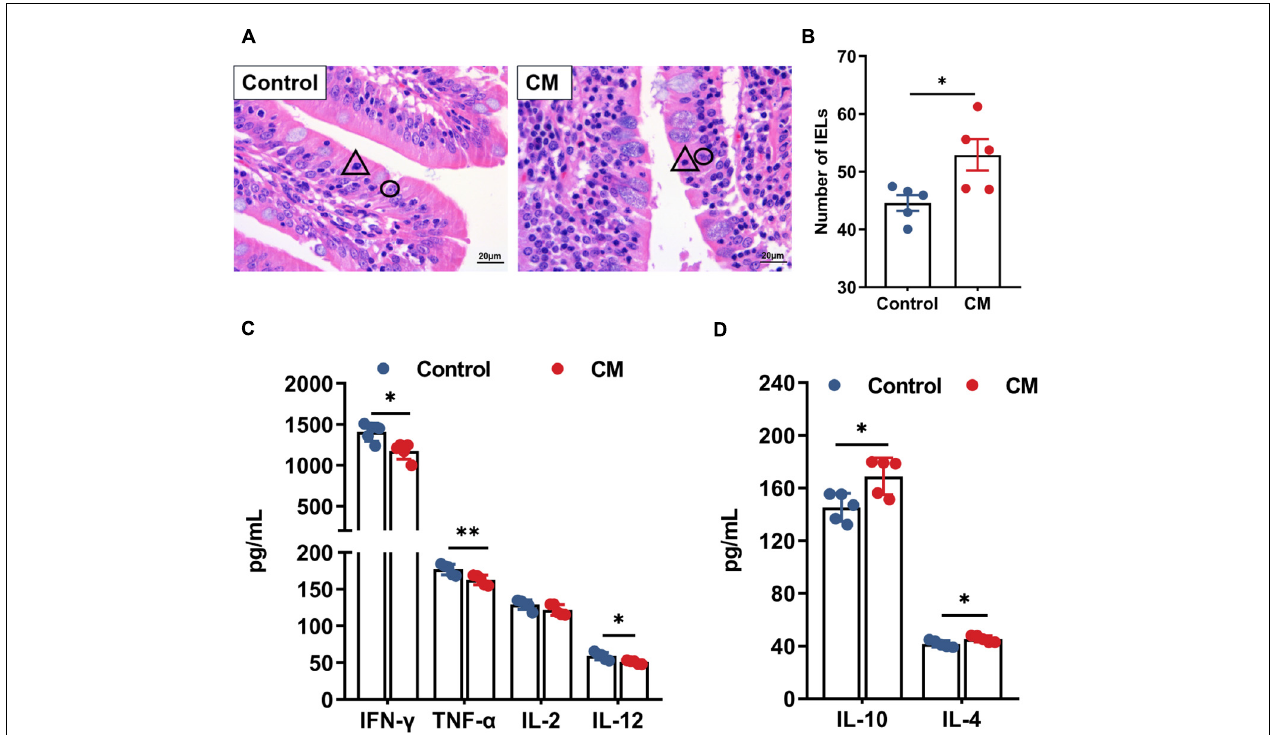
FIGURE 3 | CM improves immunological barrier function. (A) Hematoxylin-eosin stained sections of the duodenum, (cid:77) represents intestinal intraepithelial lymphocytes, and ◦ represents intestinal epithelial cells. (B) The number of intraepithelial lymphocytes was counted and analyzed. (C,D) ELISA analysis of the levels of pro-inflammatory cytokines and anti-inflammatory cytokines in the duodenal mucosa. Control, pigs fed a basal diet; CM, pigs fed the basal diet supplemented with CM at 300 mg/kg. Data are presented as the mean ± SEM ( n = 5). ∗ P < 0.05, ∗∗ P <